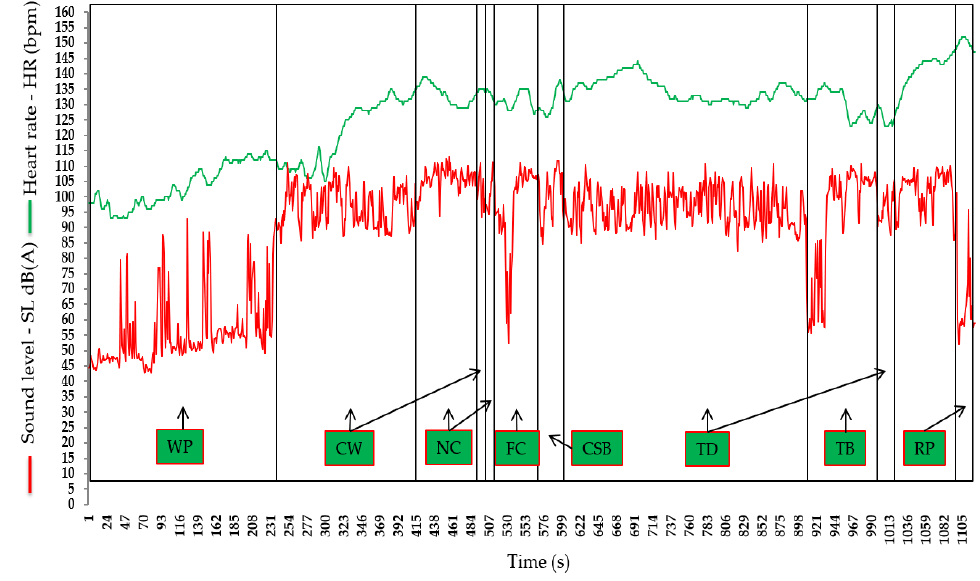
Figure 3. Conceptual framework of data pairing using the time labels and codes: WP: work preparation; CW: clearing the workplace; NC: notch cutting; FC: felling cut; CSB: clearing the stump and the bole; TF: technical delay; TB: tree bucking; RP: rest pause.